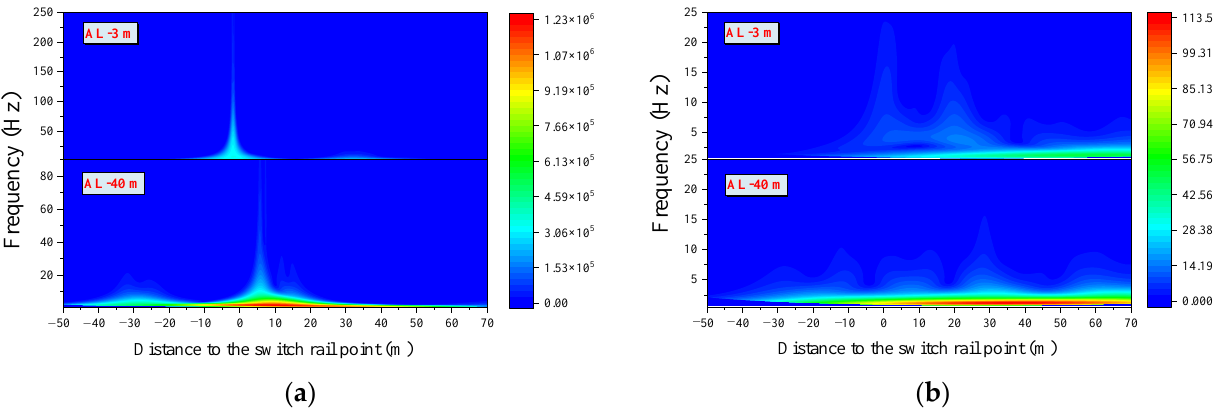
Figure 13. Time-frequency graphs of dynamic indicators at the AL in front of the turnout: ( a ) Wheelset lateral force; ( b ) Lateral acceleration of the vehicle body.